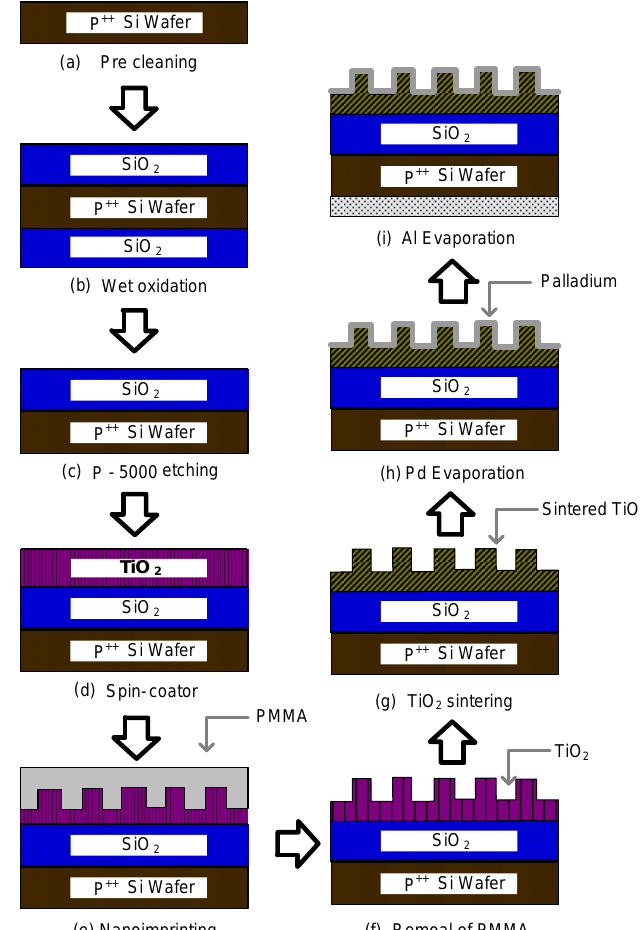
Figure 1. Schematic diagram for the gas sensor fabrication steps: (a) Silicon wafer precleaning, (b) wet oxidation in a furnace, (c) back-side of the wafer was etched using the P-5000 solution, (d) TiO layer spin-coating, (e) nano-imprinting with a premade PMMA 2 patterned mold, (f) removing the PMMA mold, (g) TiO layer sintering over 500 °C, 2 (h) Palladium layer depositing by evaporation, (i) evaporating Al on the backside of wafer to form the ohmic contact. P ++ Si